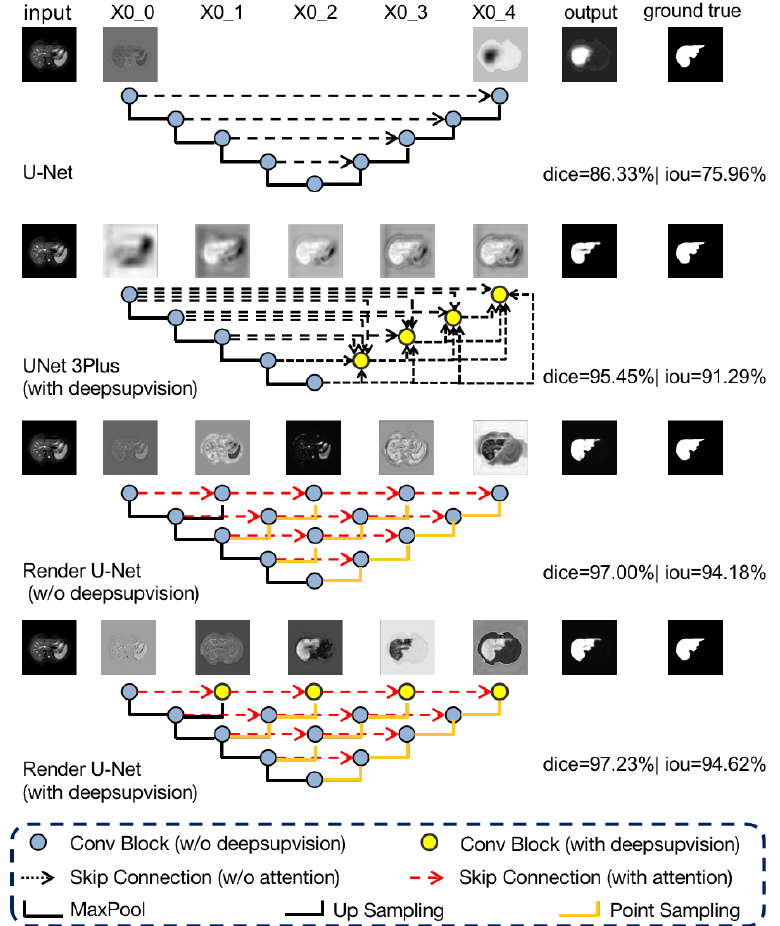
Figure 8. Visualization and comparison of feature maps along skip connections for liver MRI